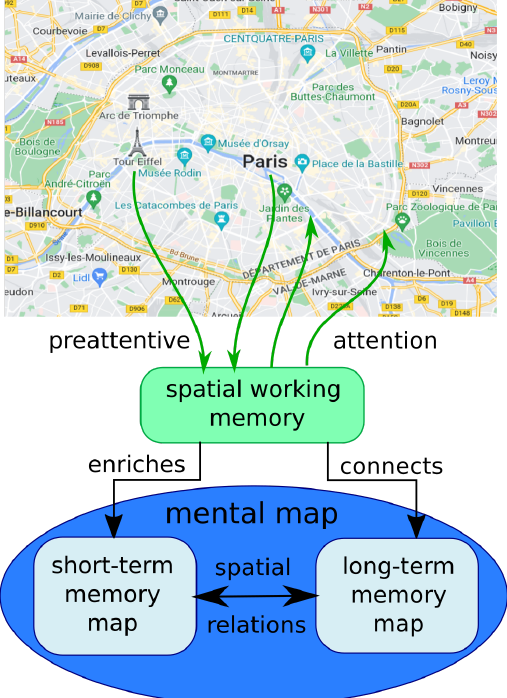
Figure 8. Reconciliation model of (dis)orientation during the exploration of pan-scalar maps. At each new view, the spatial working memory connects and reconciles the content of the map view with the mental representation of space, which is temporarily enriched by the previous views visited in the exploration